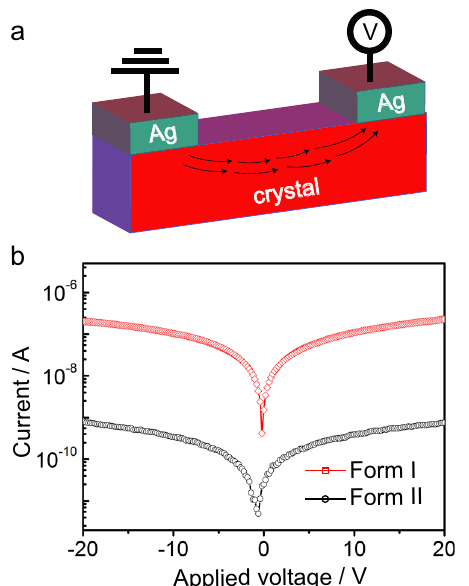
Fig. 5 The I – V (current – voltage) characteristics of form I and form II GN crystals. a Metal-ferroelectric-metal con fi guration (lateral